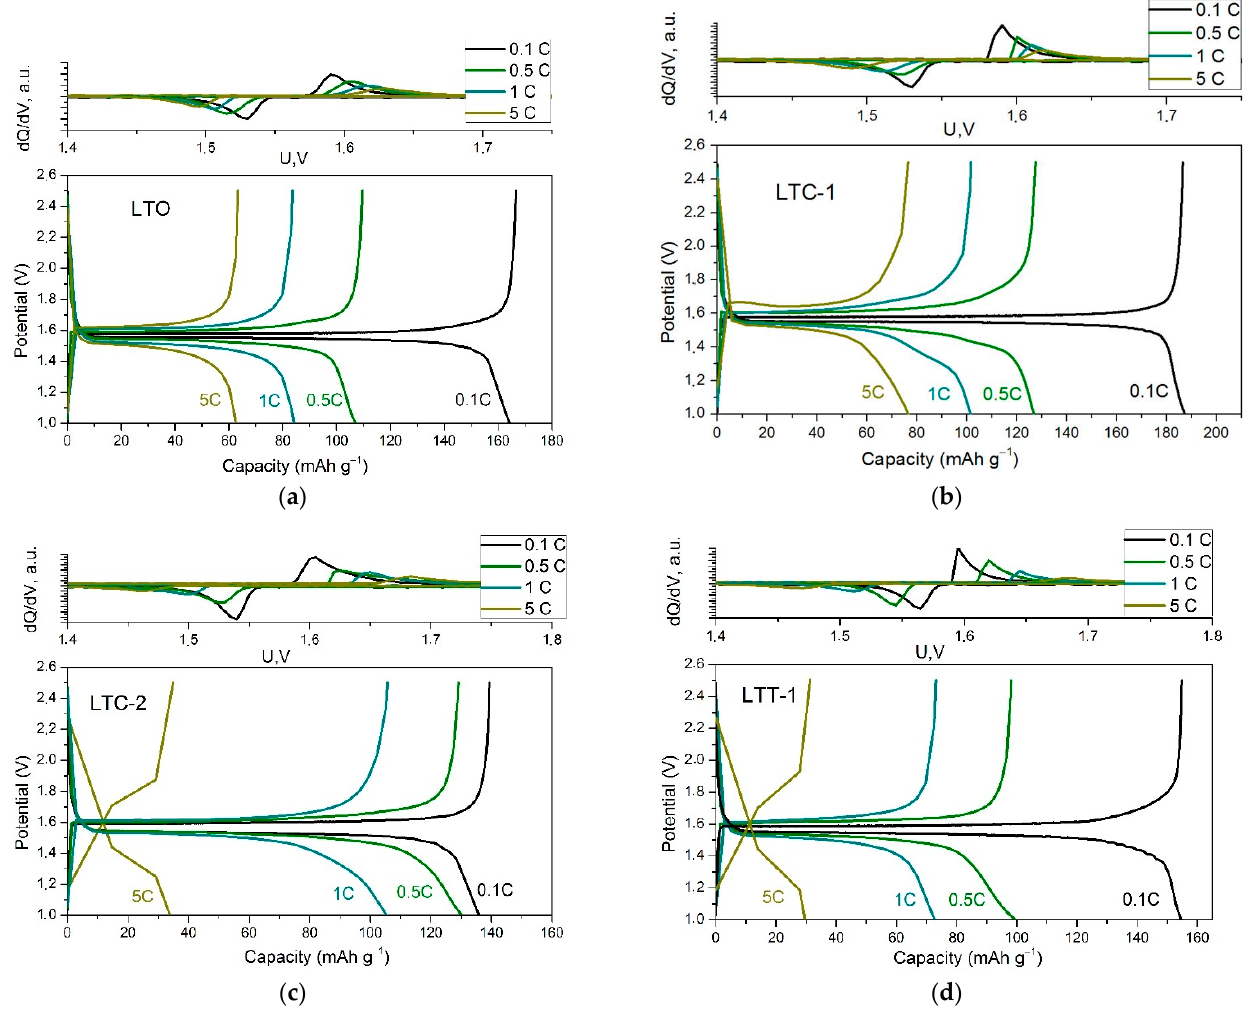
Figure 5. The charge-discharge curves obtained for the studied samples in the region of potentials 1.0–2.5 V (vs. Li + /Li°) at the 2-nd cycle at different charge/discharge rates. Corresponding dQ/dU vs. U curves are presented in the upper plot for ( a ) LTO, ( b ) LTC-1, ( c ) LTC-2 and ( d ) LTT-1 samples. The theoretical value of the electrochemical capacity for this process is 175 mAh g − 1 .